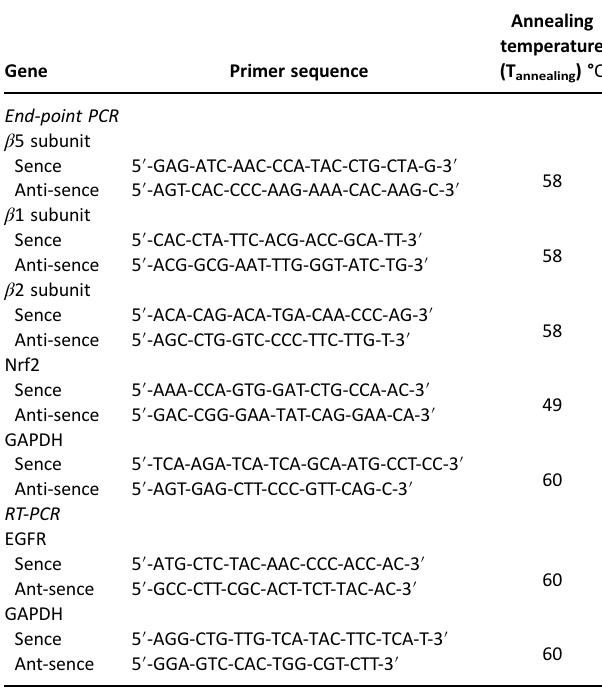
Table 1. Sequence of the primers used for end-point and RT-PCR